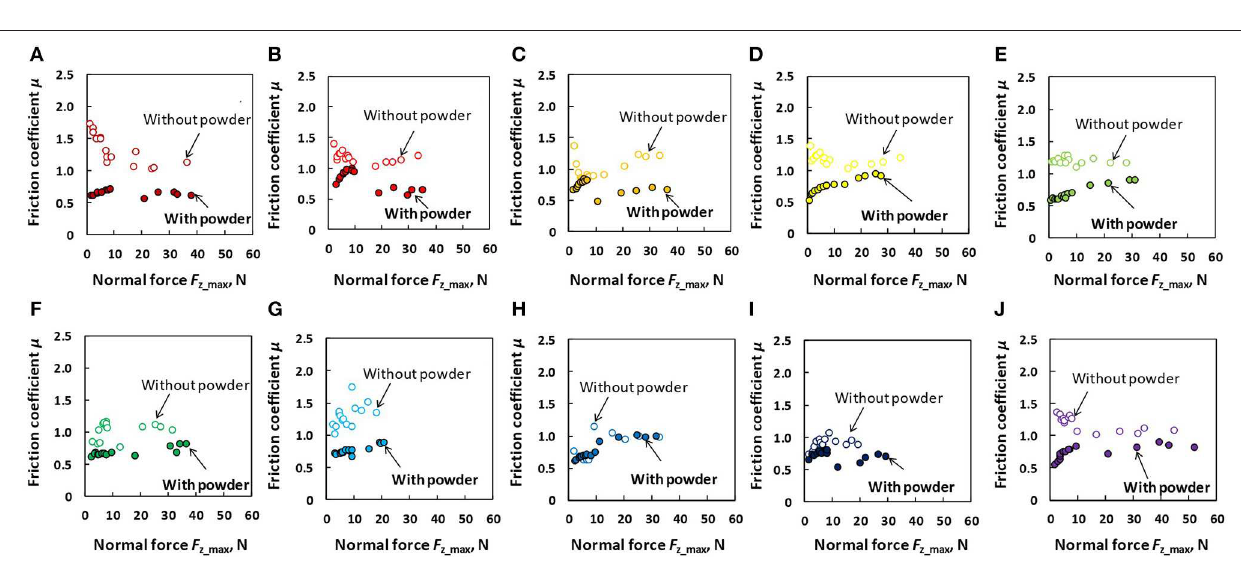
FIGURE 9 | Comparison of friction coefficient ( µ ) as a function of normal force ( F z_max ) between the dry non-powdered and dry powdered conditions for each participant. (A) Participant A, (B) participant B, (C) participant C, (D) participant D, (E) participant E, (F) participant F, (G) participant G, (H) participant H, (I) participant I, and (J) participant